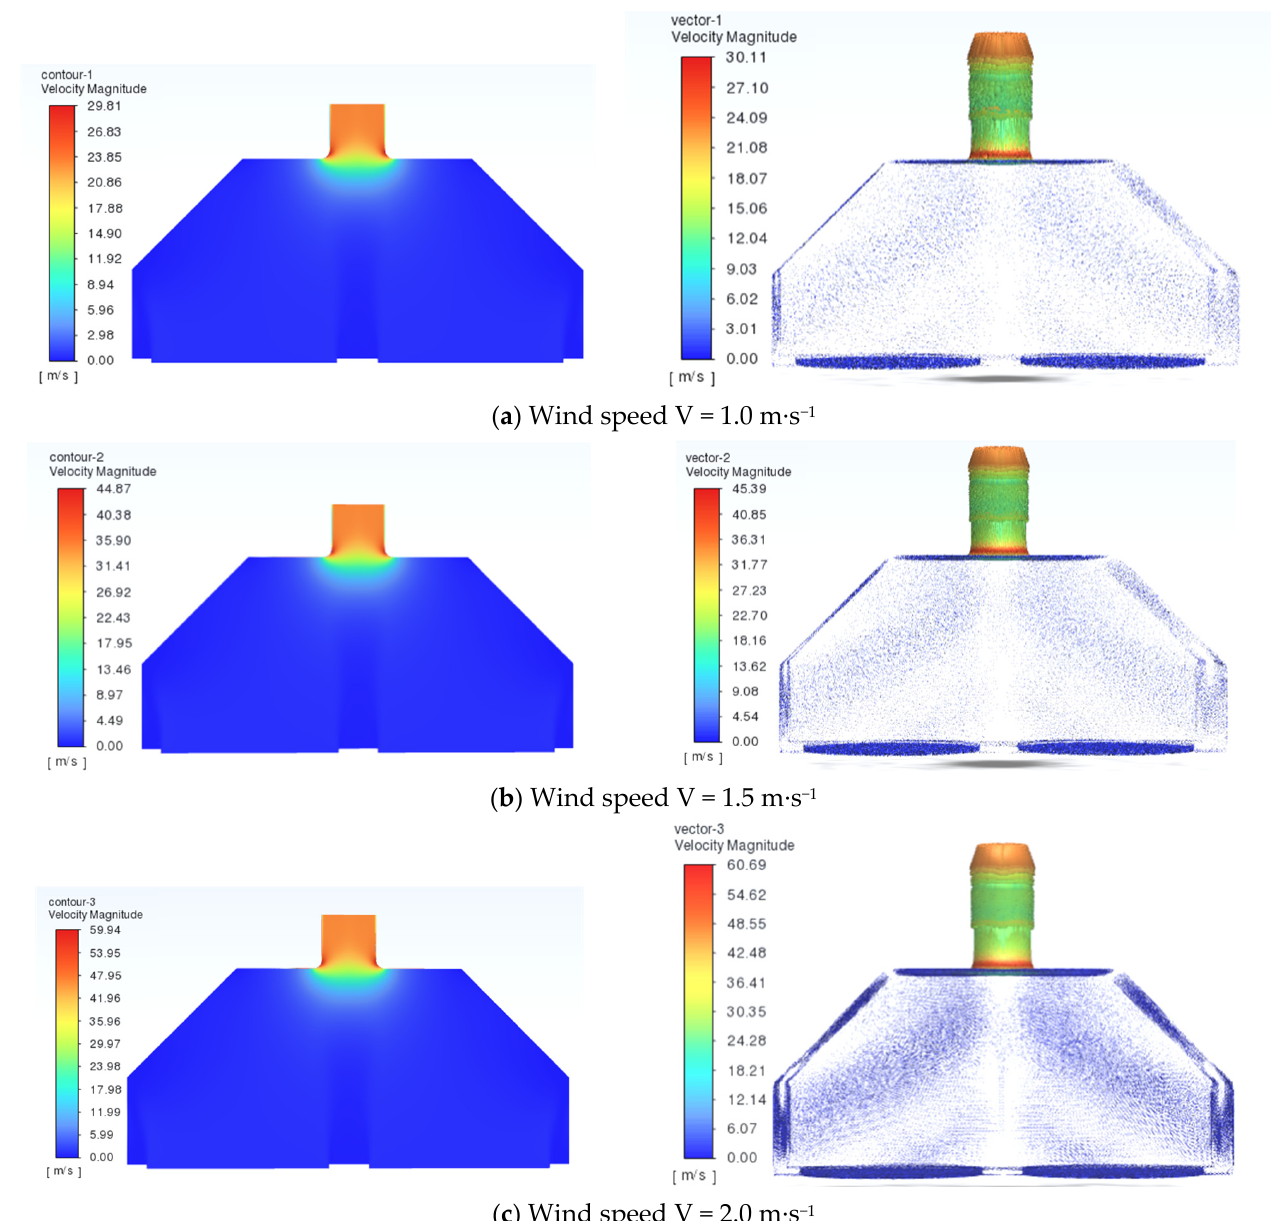
Figure 9. Velocity nephogram and velocity vector diagram under di ff erent wind speeds.